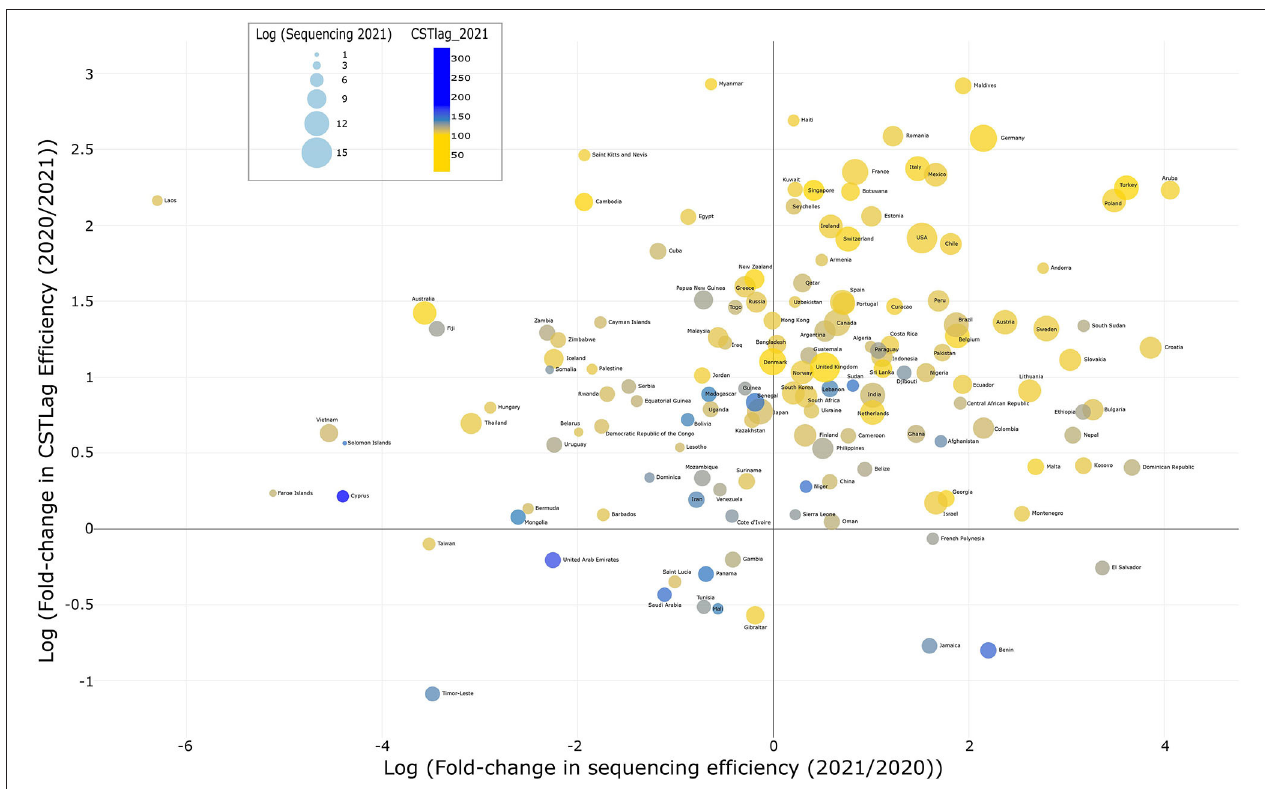
FIGURE 1 | Mapping genomic surveillance efficiency: This bubble plot illustrates selected countries’ comparative genome surveillance efficiency based on (i) sequencing efficiency and (ii) CSTlag efficiency in 2021 compared to 2020. The color and size of the bubble depict the median CSTlag per country and the number of submitted genomes in 2021, respectively. An interactive version, showing all countries’ comparative genome surveillance efficiency, can be downloaded using this link https://drive.google.com/file/d/17TZ2RRgY84xlnbuFuGueokrqmThWZ5Jp/view?usp=sharing and visualized in an internet browser.